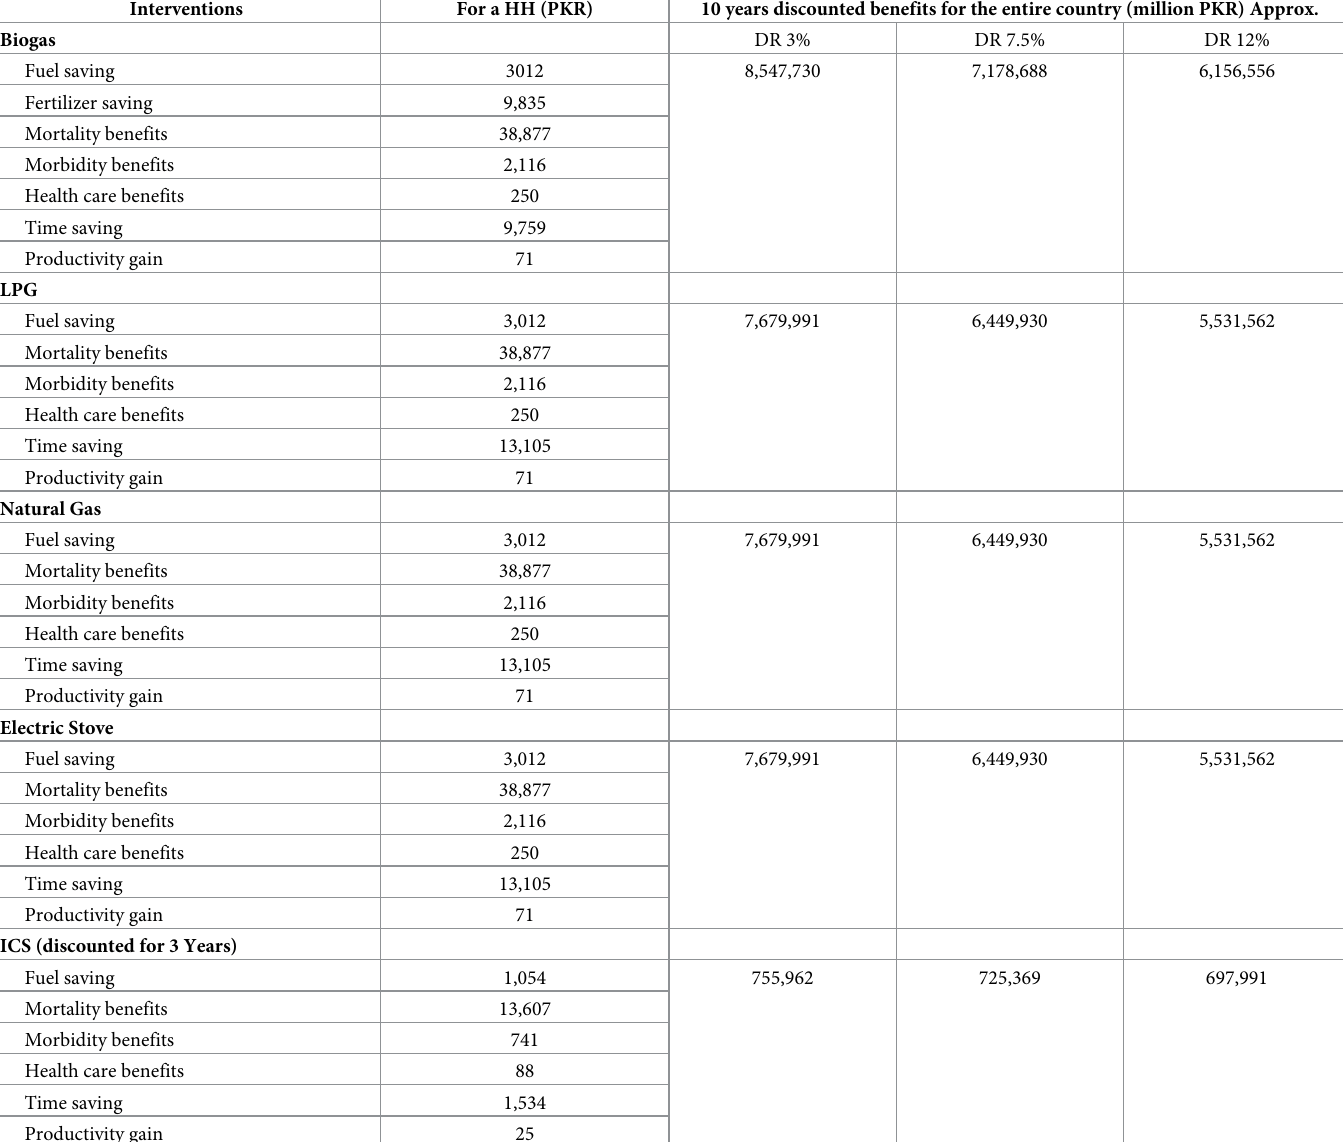
Table 3. Summary of the Benefits for all interventions. Interventions For a HH (PKR) 10 years discounted benefits for the entire country (million PKR) Approx. DR 3% DR